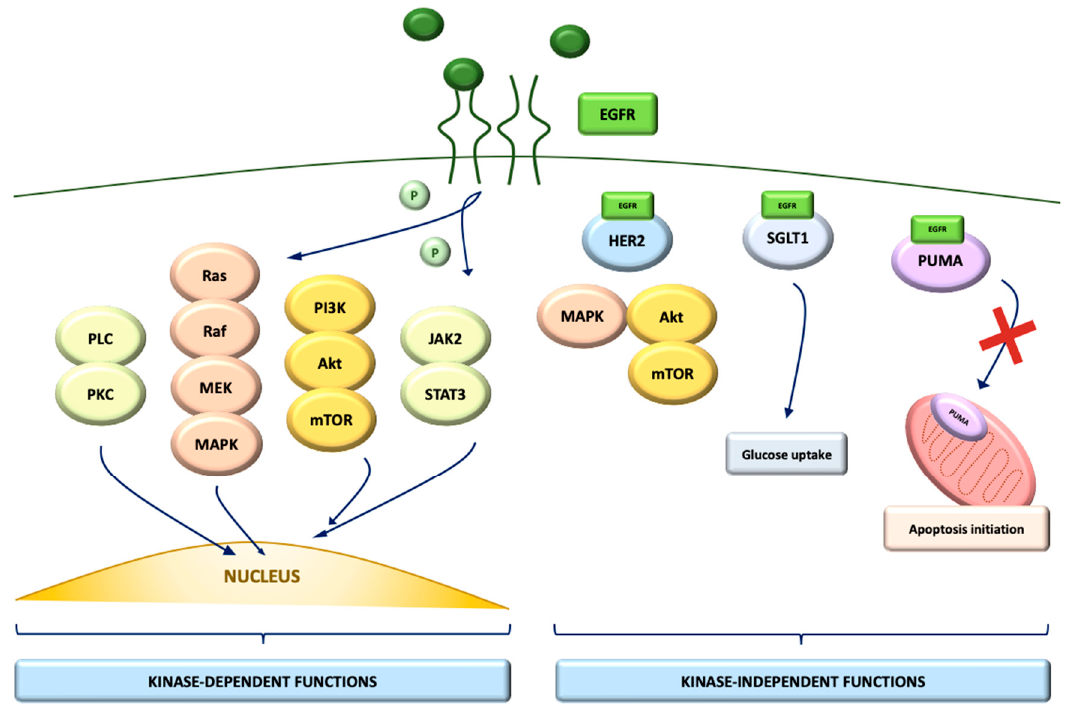
Figure 1. EGFR tyrosine-kinase dependent and independent signaling pathways.